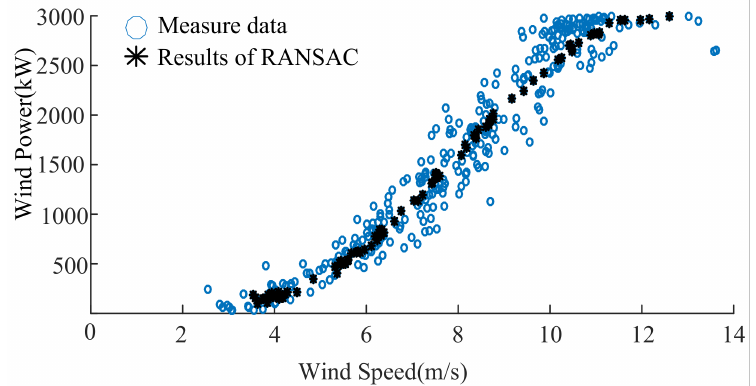
Figure 5. Result of RANSAC for the operational data.